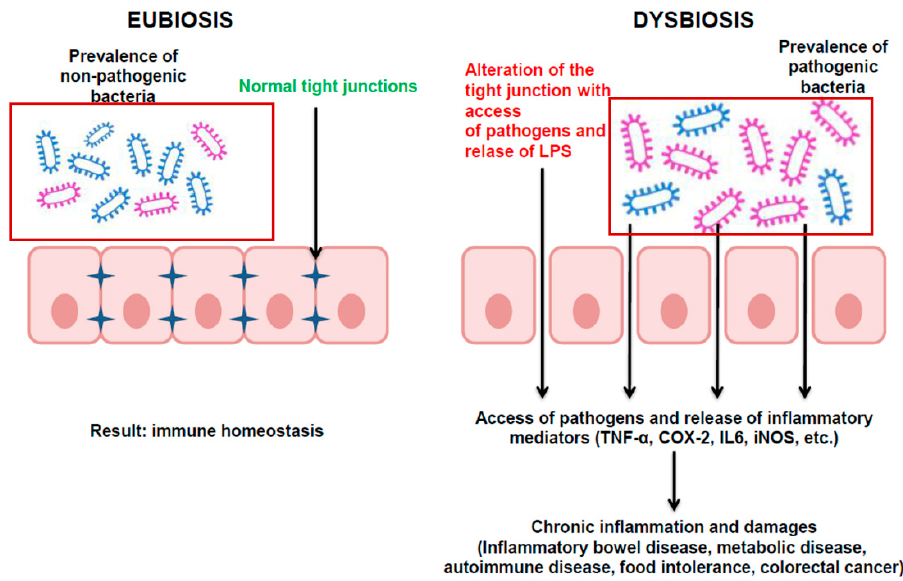
Figure 1. The delicate equilibrium between eubiosis and dysbiosis in the bowels. Eubiosis is the condition in which saprophytic bacteria are present in the mucus-microbiotic layer of the bowel (either the small or the large one). Dysbiosis is a condition in which pathogenic bacteria (Pathogenic bacteria are represented with purple frame, non-pathogenic have a blue frame) predominate and cause changes in the intercellular tight junctions and, in turn, activation of the MALT, leading to tissue damage.